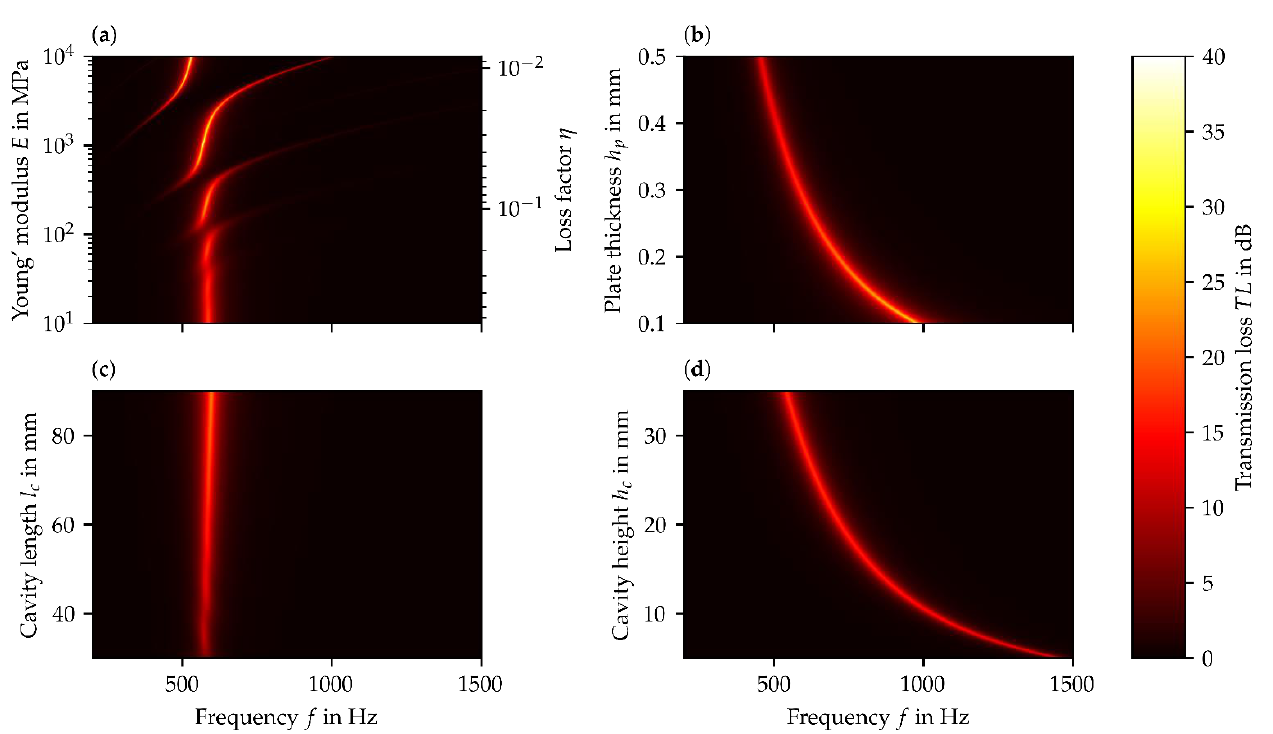
Figure 8. Results of the parameter study of the plate silencer, ( a ) variation of Young’s modulus E and loss factor η , ( b ) variation of plate thickness h p , ( c ) variation of plate length l p , ( d ) variation of cavity height h c